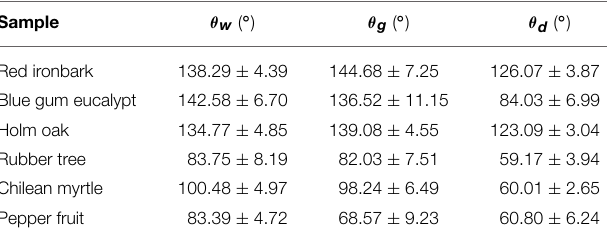
TABLE 2 | Contact angles of water ( θ w ), glycerol ( θ g ) and diiodomethane ( θ d ) on the upper side of red ironbark, blue gum eucalypt, rubber tree and Chilean myrtle leaves, lower side of holm oak leaves, and pepper fruit